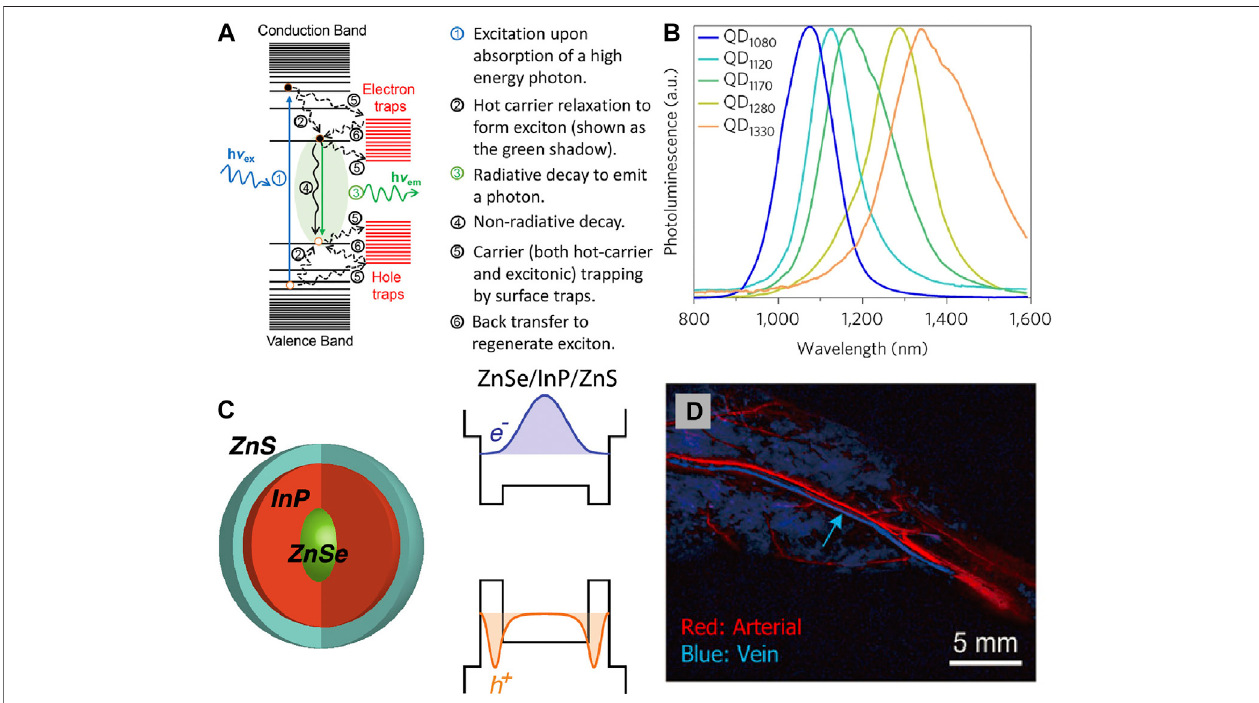
FIGURE3|(A) Schematicofbasicprocessesinvolvingvariousexcitedstatesinaquantumdotuponphotoexcitation(Puetal.,2017).Reproducedwithpermission from Peng et al. (2017). (B) Spectra of different core/shell short-wave infrared quantum dots: QD 1080 (InAs(CdSe) 1 (ZnSe) 3 ); QD 1120 (InAs(CdSe) 1.5 ); QD 1170 (InAs(CdSe) 3 ); QD 1280 (InAs(Cd 0.9 Zn 0.1 S)); QD 1330 (InAs(CdSe) 6 ) (Bruns et al., 2017). Reproduced with permission from Bruns et al. (2017). (C) NIR emission ZnSe/InP/ ZnS core/shell/shell nanoparticles and their bandgap alignments with corresponding electron and hole wave functions (Saeboe et al., 2021). Reproduced with permission from Dennis et al. (2021). (D) PCA for differentiation of arterial and venous components (Zhang et al., 2018). Reproduced with permission from Zhang et al.